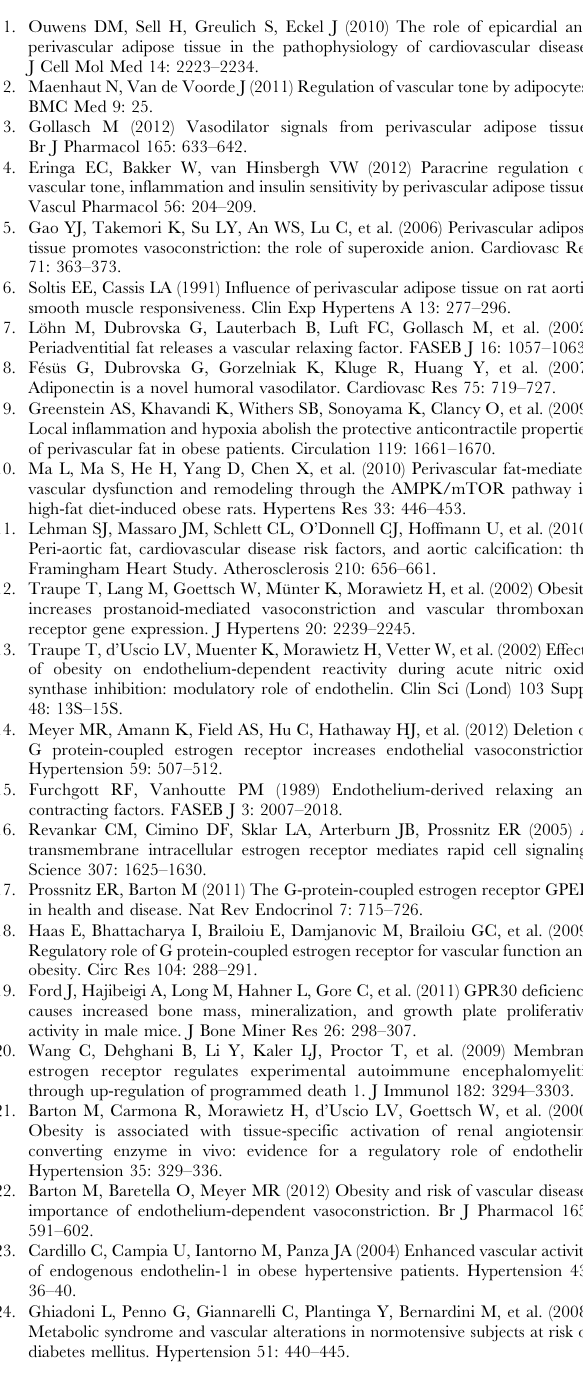
Table S1 Sets of primers used for amplification of gene- specific cDNA fragments by qPCR. TNF a , tumor necrosis factor a ; PPAR c , peroxisome proliferator activated receptor c ; COX,